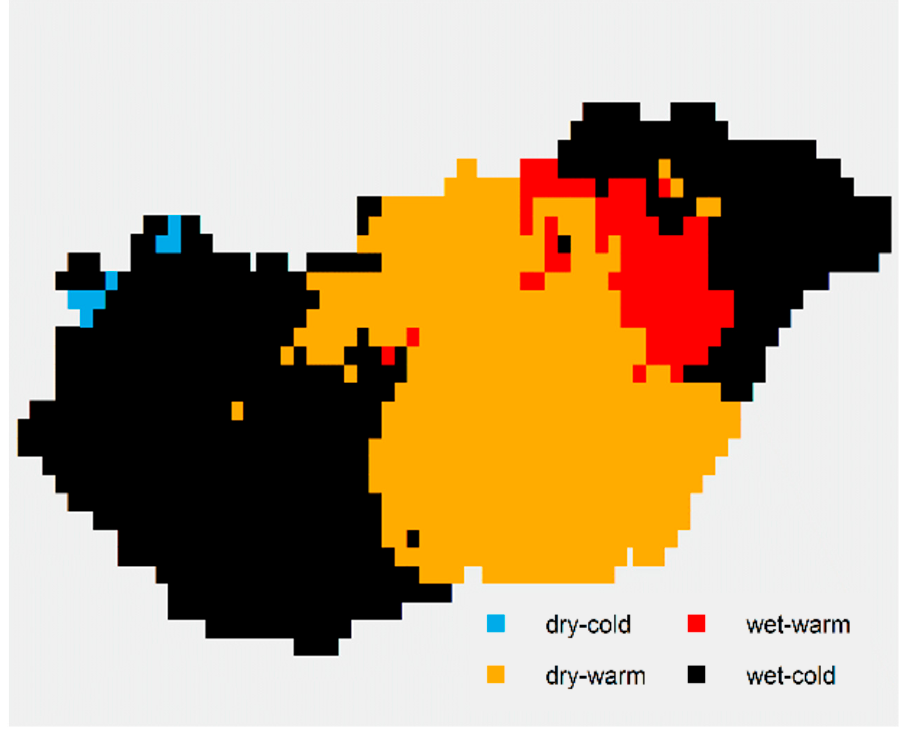
Figure A2. Characteristics of extreme months (February).